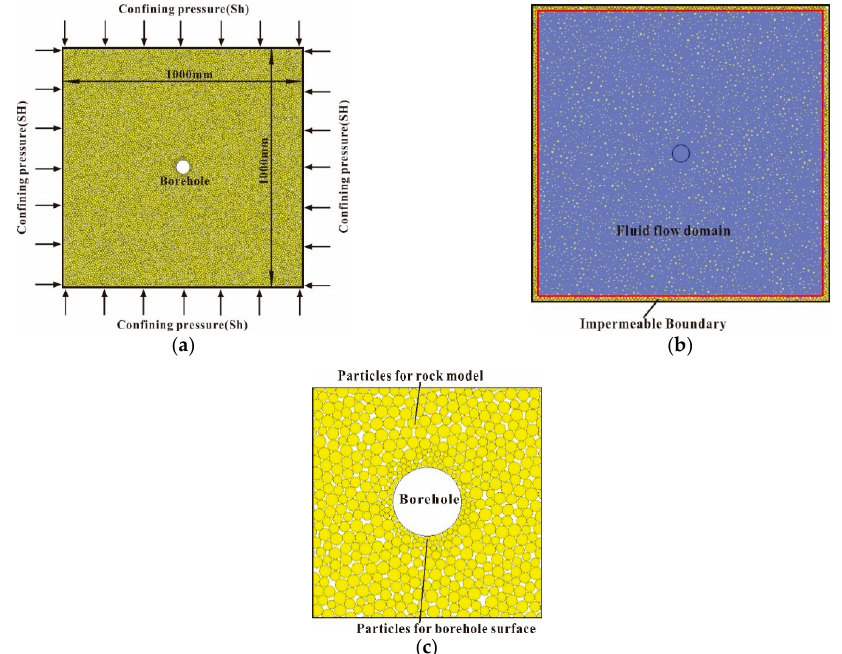
Figure 5. Rock specimen model and loading conditions: ( a ) rock specimen model and loading condition; ( b ) fluid flow domain and impermeable boundary; and ( c ) particle packing method near borehole. Table 1. Rock model properties and input micro-parameters.